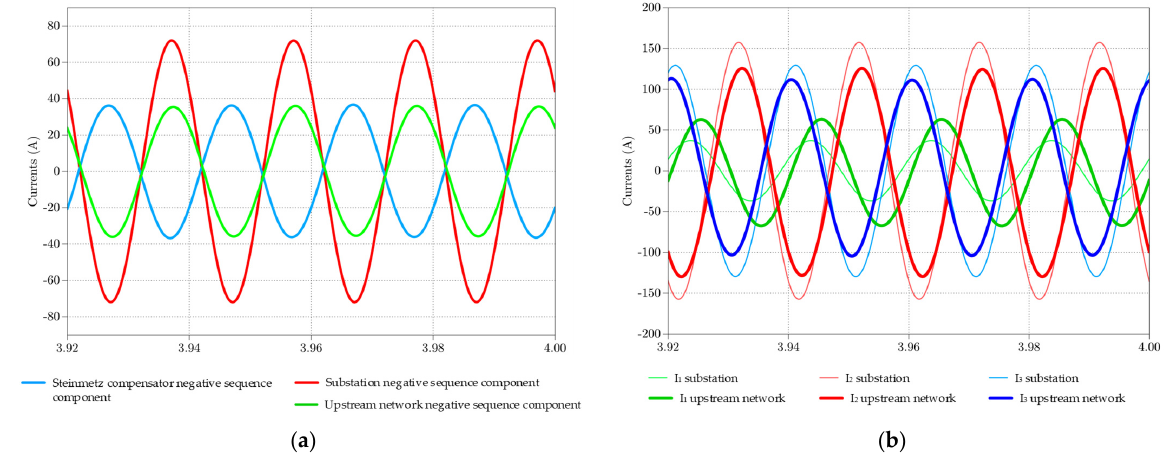
Figure 12. ( a ) Negative sequence currents. ( b ) Substation currents (primary of both transformers T1 and T2) and upstream network currents.